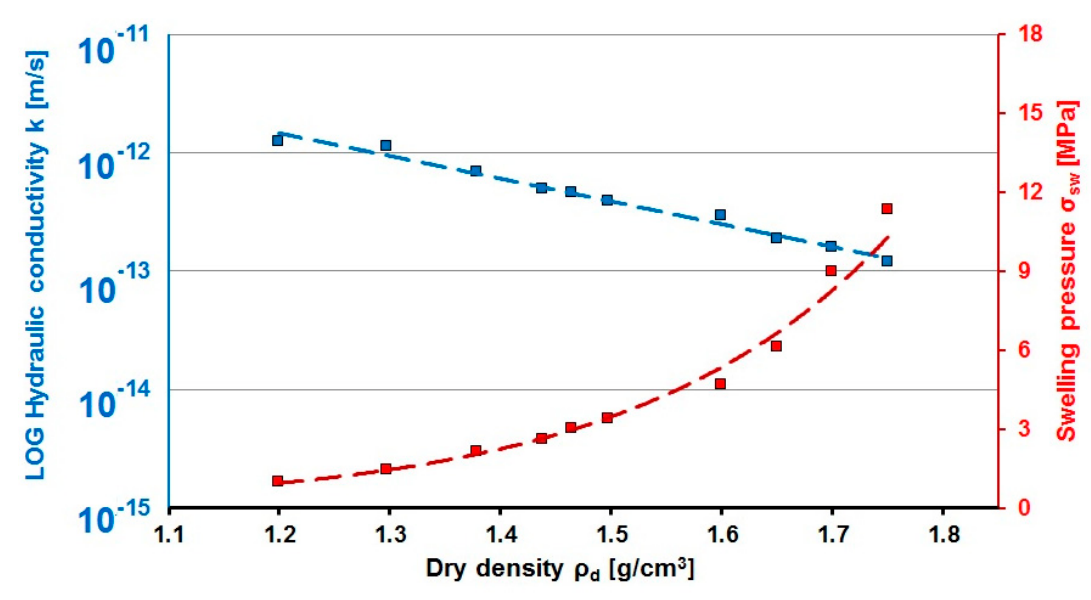
Figure 2. Hydraulic conductivity and swelling pressure values for the selected B75 raw material